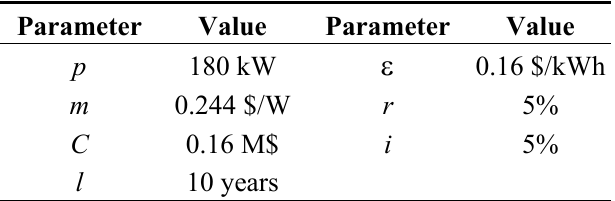
Table 4. Necessary parameters for calculating economic